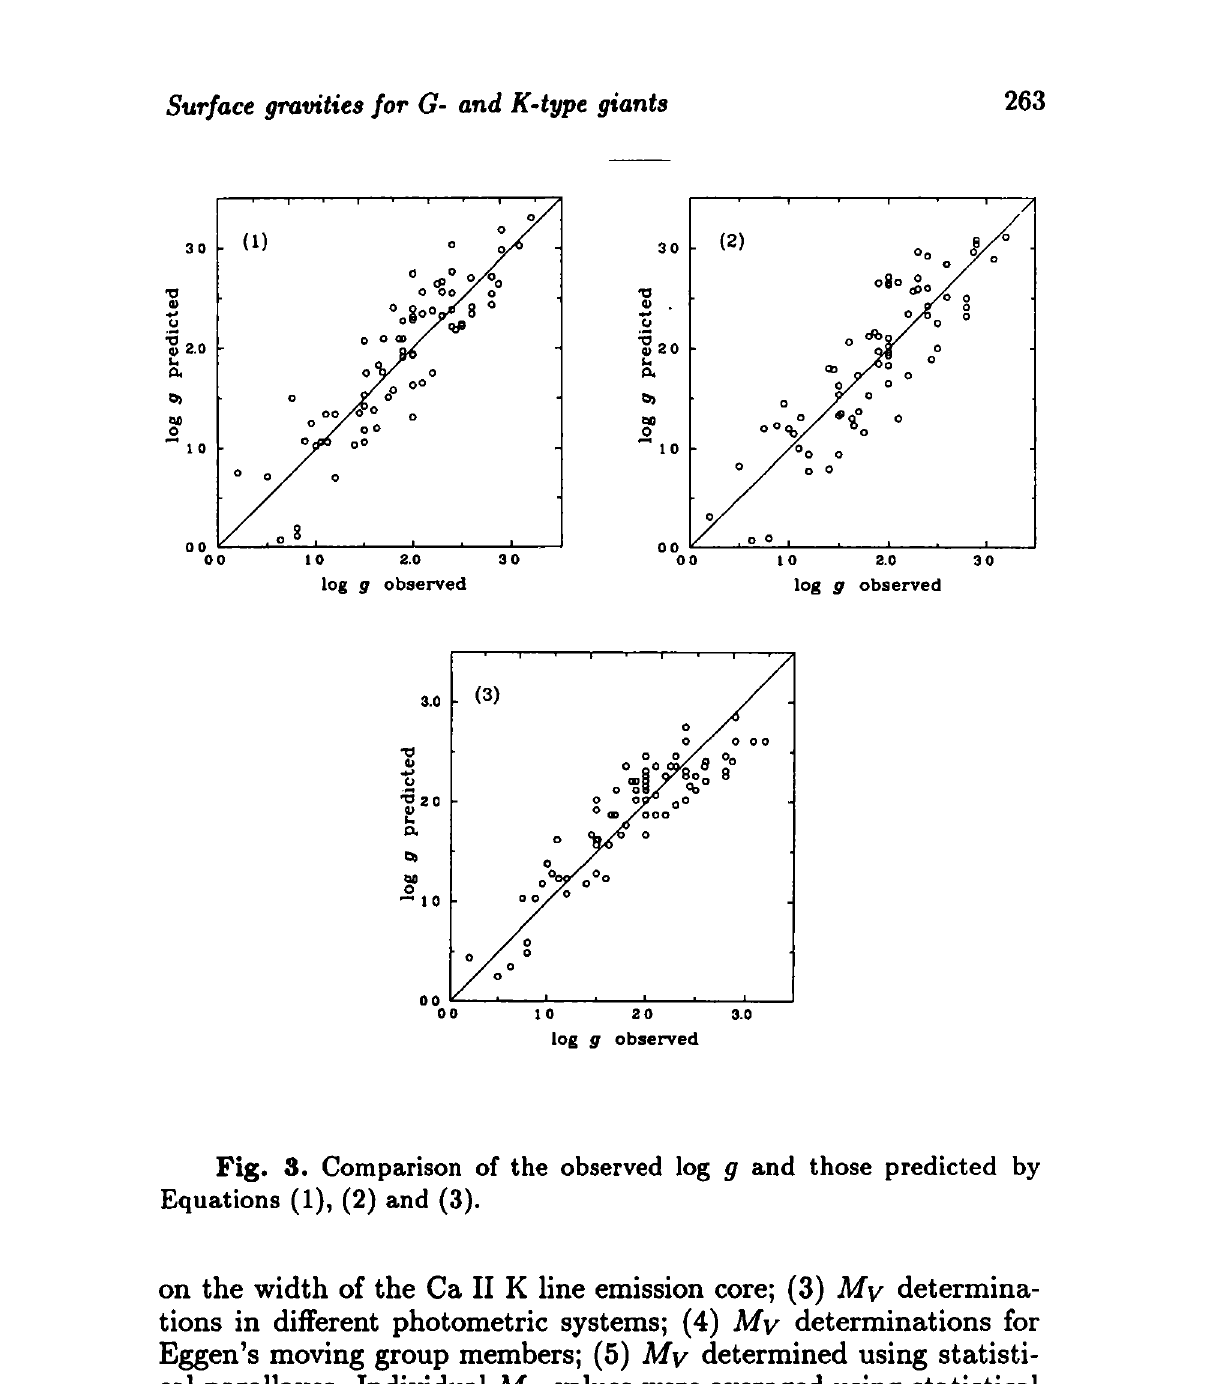
Fig. 3. Comparison of the observed log g and those predicted by Equations (1), (2) and